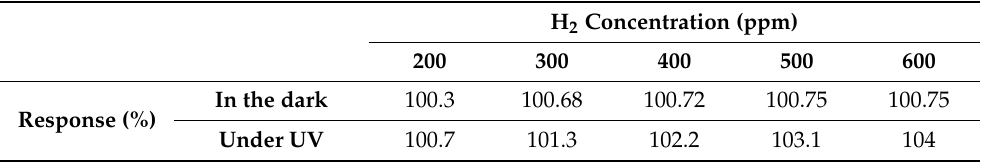
Table 1. Hydrogen sensing response of Dy 2 O 3 -Pd-PDA/rGO conductometric sensor in the dark and under UV illumination at 150 ◦ C and 0 %RH towards H 2 with different concentrations.